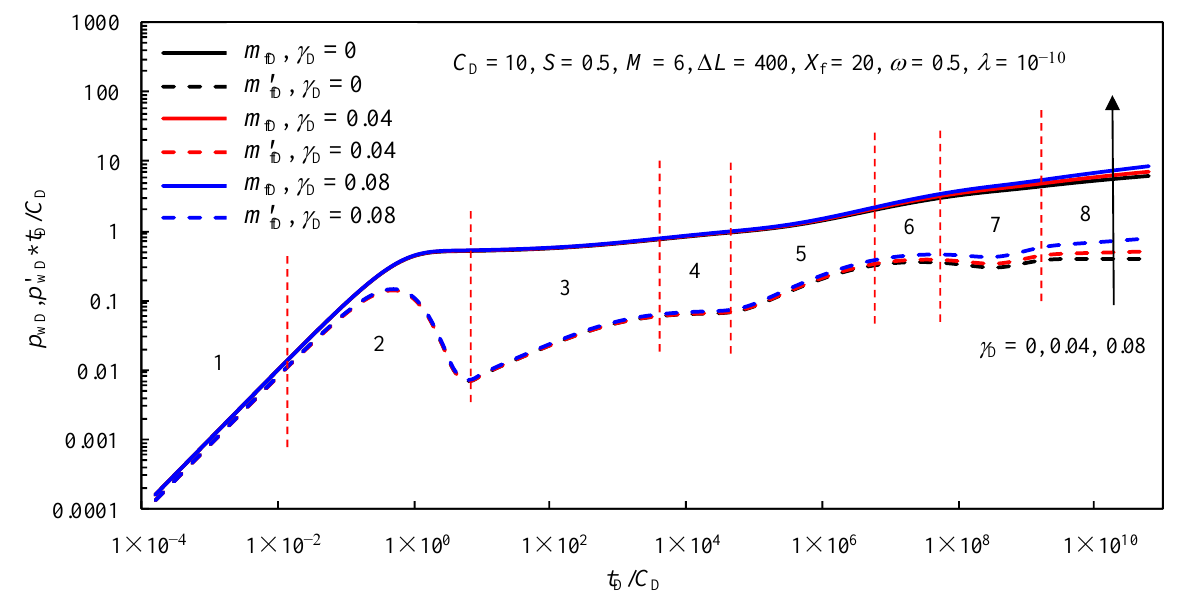
Figure 5. The effect of stress sensitivity on the dimensionless pressure and pressure derivatives of a MFHW in an inter-salt shale oil reservoir.